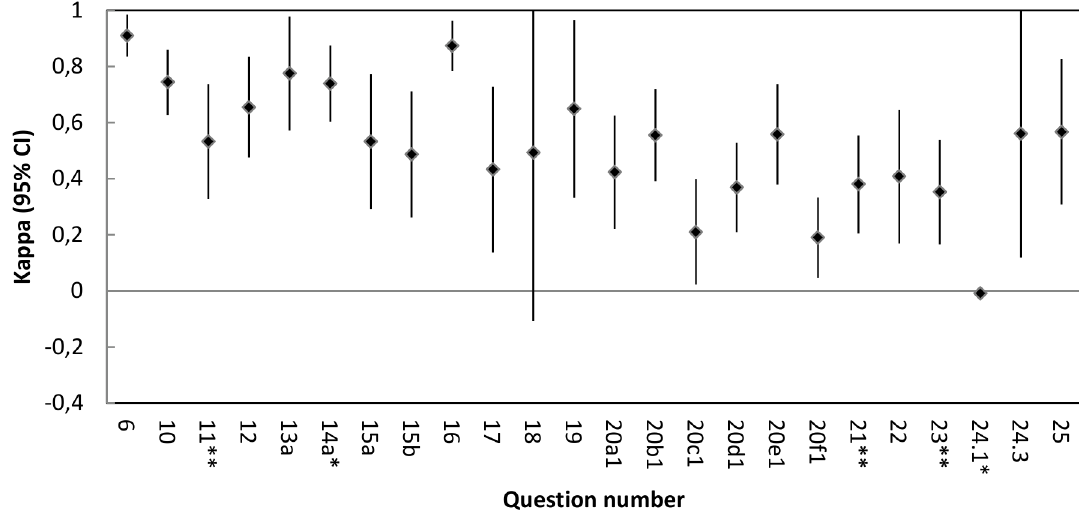
Fig 2. Cohen’s kappa values and 95% confidence intervals for 24 ELQ items. * Items used to calculatequality indicators. ** Items used to calculatequality indicators under development.